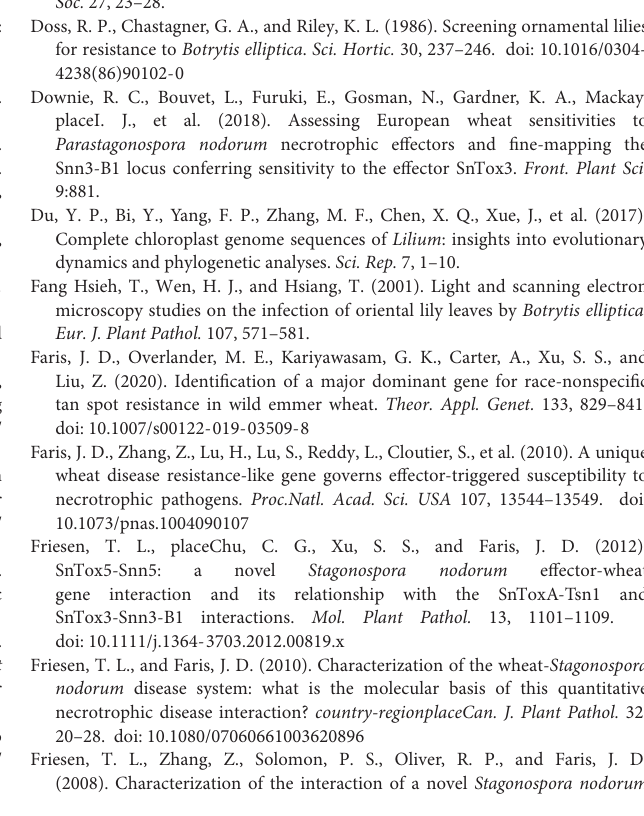
cut off for estimated differences which are significantly different from 0 ( p > 0.05). P -values were adjusted using Tukey’s comparison for a family of 24 estimated. Supplementary Table 1 | ANOVA results of the interaction in flowers between 12 Lilium genotypes and three B. elliptica and one B. cinerea isolates measured as lesion diameter. Analysis of Variance with Satterthwaite’s method. P -value ≤ 0.05. The experiment tests the random effect of one experiment. Terms are as follow: be, the three B. elliptica and one B. cinerea isolates tested; group, the six lily hybrid groups tested. In addition, interactions of these factors were tested (:). The degrees of freedom and p -value are shown. Supplementary Table 2 | ANOVA results of the interaction in leaves of cut lilies between 12 Lilium genotypes and three B. elliptica and one B. cinerea isolates measured as lesion diameter. Analysis of Variance with Satterthwaite’s method. P -value ≤ 0.05. The experiment tests the random effect of one experiment. Terms are as follow: be, the three B. elliptica and one B. cinerea isolates tested; group, the six lily hybrid groups tested. In addition, interactions of these factors were tested (:). The degrees of freedom and p -value are shown. lilies genotypes inoculated with three B. elliptica isolates (Be9401, Be0006, and Be9732) and one B. cinerea isolate Bcin_B05.10. Supplementary Material 2 | Results of Multiple Comparison Analysis and EEMs conducted on lesion diameters scored in the four repetition of the main disease assays in lily leaves and on lesion diameters scored in the disease assays on flowers and leaves of cut